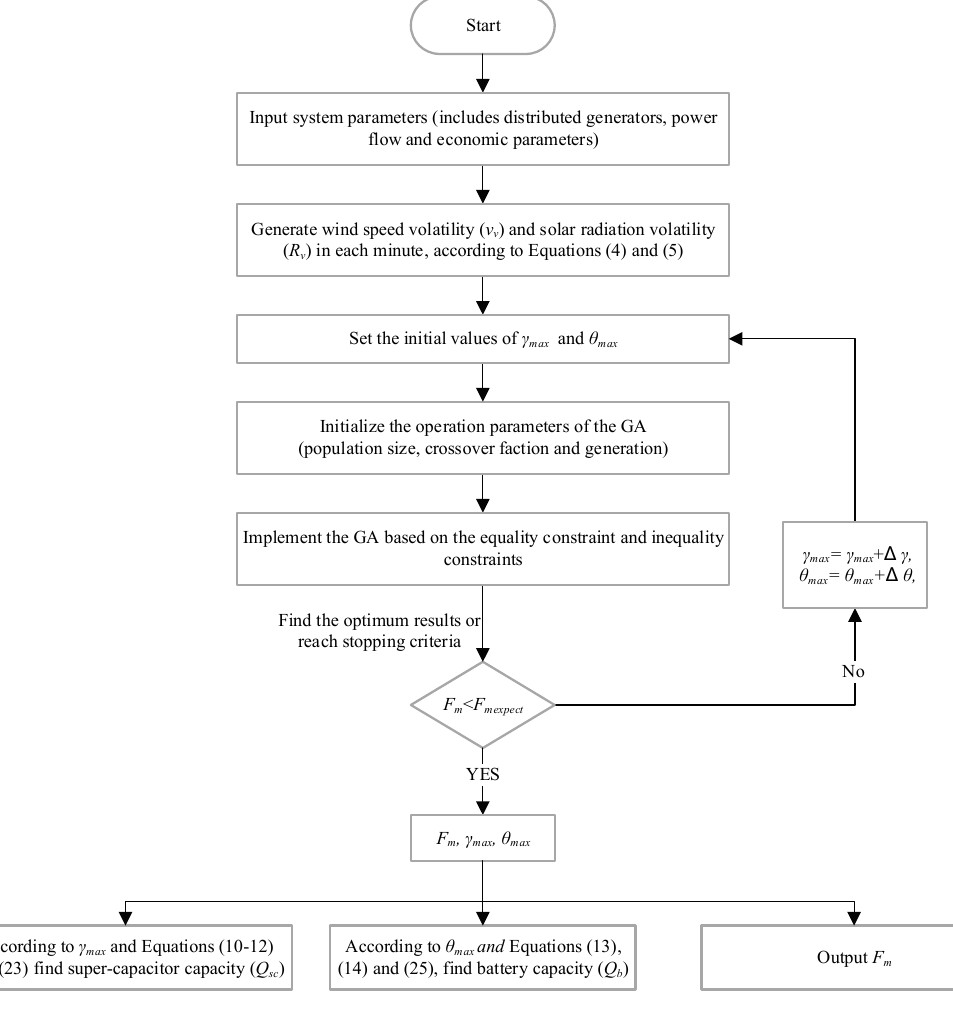
Figure 2. The flow diagram of the proposed genetic algorithm (GA).